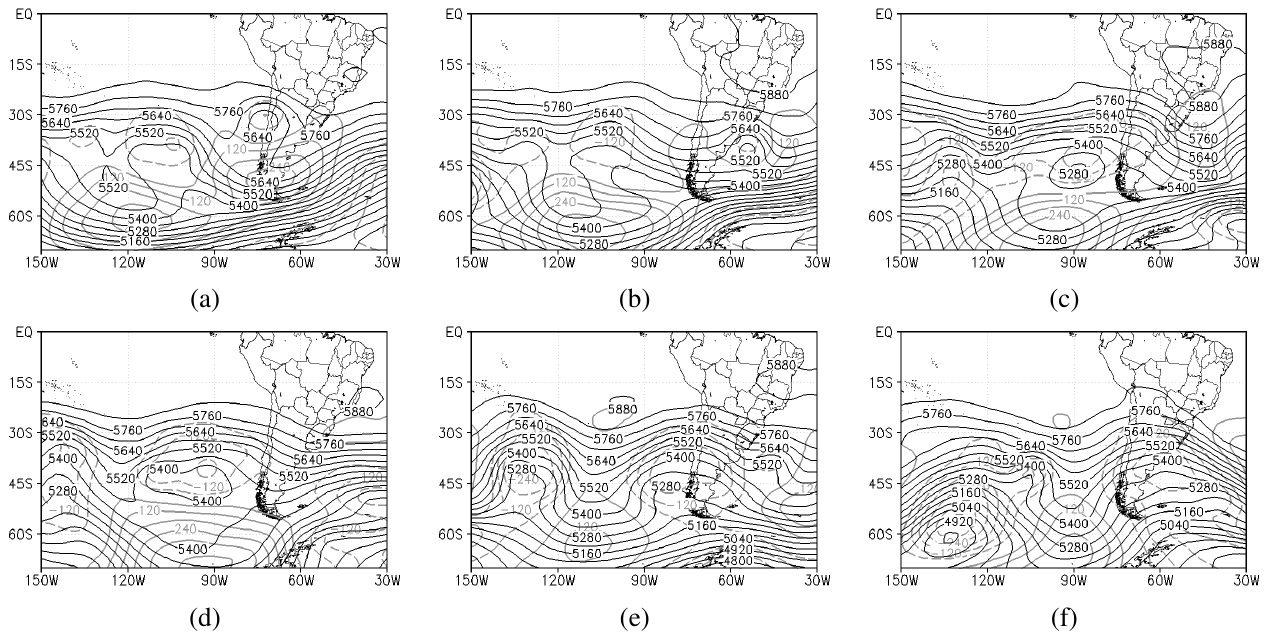
Fig. 9. 500-hPa geopotential height (m) and its anomaly for (a) 24, (b) 26, (c) 31 August, (d) 3, (e) 7, (f) 9 September 1999 at 00:00 UTC. Darker lines are geopotential and lighter lines are anomalies. Broken lines indicate negative anomalies.